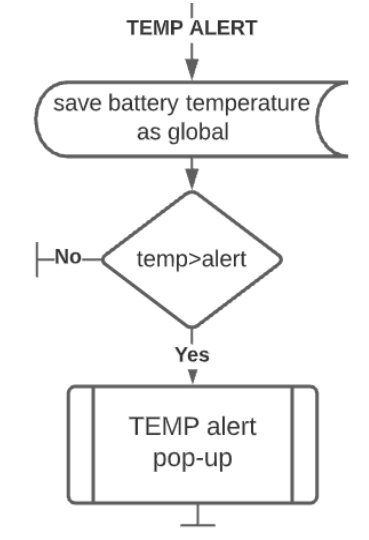
Figure 11. Temperature alert functionality